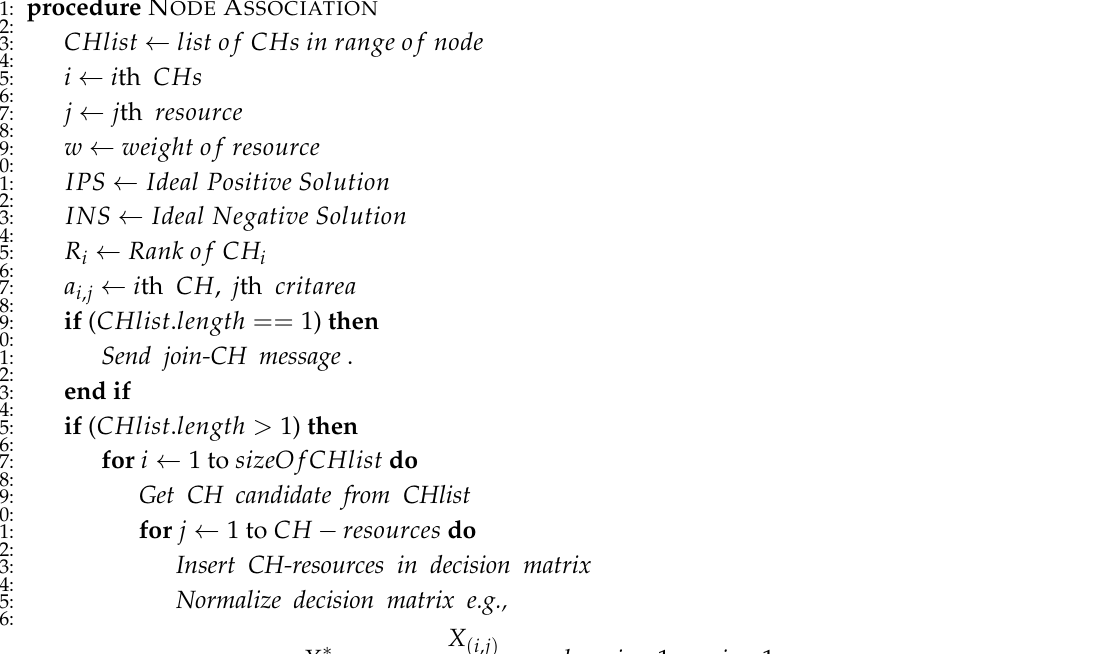
Algorithm 2 New Node(s) Association